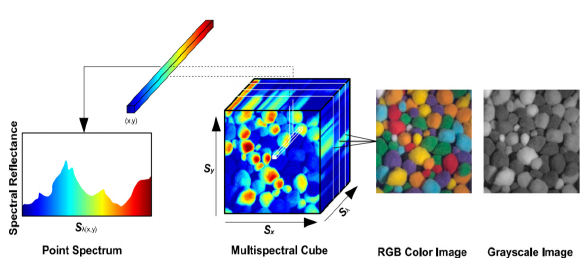
Figure1: A hyperspectral image represented as a 3D cube, S λ represent number of bands. Derived RGB and grayscale images (Khan, et al., 2013)